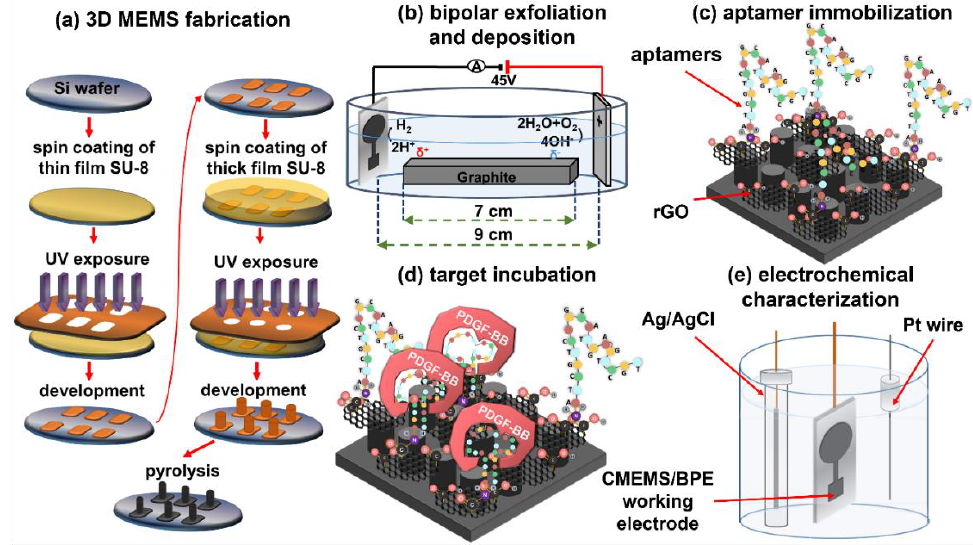
Figure 1. Schematic illustration of ( a ) 3D C-MEMS microfabrication process, ( b ) bipolar exfoliation cell, ( c ) development of C-MEMS/BPE/Apt PDGF-BB aptasensors, ( d ) target incubation, and ( e ) three-electrode electrochemical cell with Ag/AgCl reference electrode, Pt wire counter electrode, and C-MEMS/BPE/Apt in 5 mL aqueous electrolytes of 0.1 M PBS/5 mM K 3 Fe(CN) 6 /0.2 M KCl.